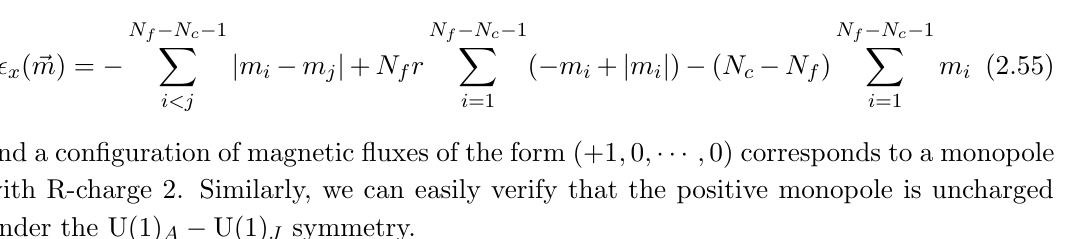
Table 2 . Computation of the superconformal index for di(cid:11)erent values of N c and N f up to order (cid:0) (cid:1) O x h . In the last column we report the (cid:12)rst terms of the expansion. From the exponent of the overall factor of x , we see indeed that the R-charge of the monopoles